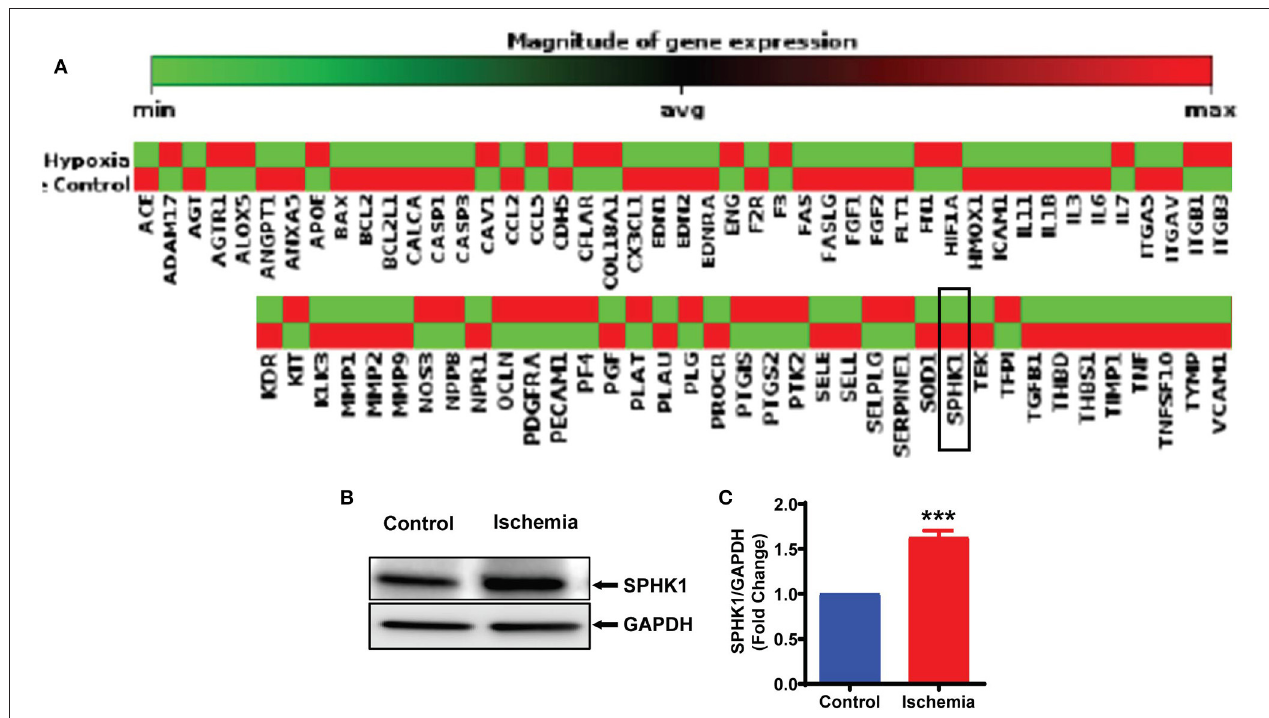
FIGURE 5 | Ischemia-induced SPHK1 expression in endothelial cells. (A) HMVE cells were cultured under hypoxia (under 1% O 2 levels) and mRNA was isolated for RT 2 profiler PCR array for genes implicated in endothelial cell biology. SPHK1 gene expression was downregulated following hypoxia. (B) HMVE cells were cultured under LPS with hypoxia for 24 h and protein lysates were prepared for western blotting. (C) SPHK1 protein was significantly upregulated by LPS with hypoxia treatment. SPHK1 bands intensity were quantified using ImageJ (NIH) from 3 independent experiments. Data represented as means ± SEM. *** P < 0.001, control vs. 24 h ischemia ( n =